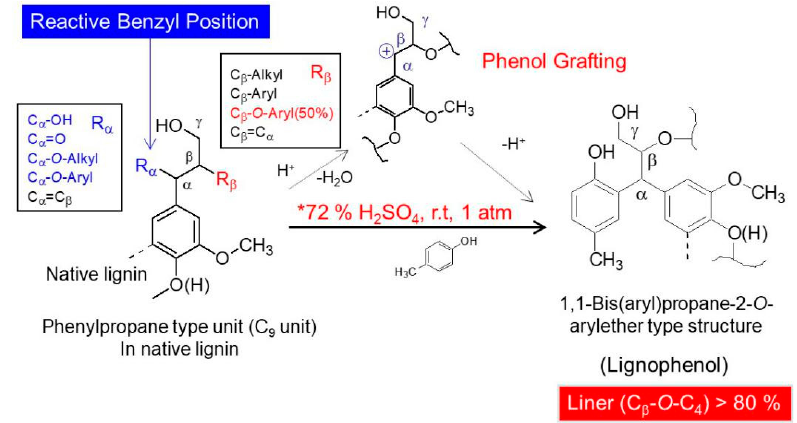
Figure 1. A schematic model of phase separation system [8].